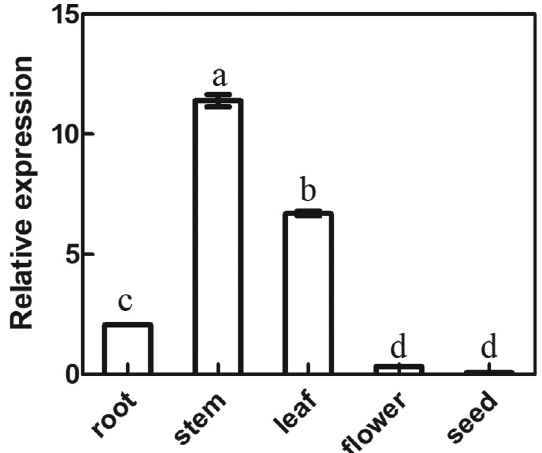
Figure 3 - Analysis of Df4CL2 expression levels in TT using Real-time PCR and 18S rRNA as internal control. Each histogram represents the meanofthreebiologicalreplicates.Meansandstandarddeviations(SD)(n = 3) of at least three independent experiments are reported. Different let- ters indicate significant difference ( p < 0.05, one-way ANOVA, followed by Duncan’s test).